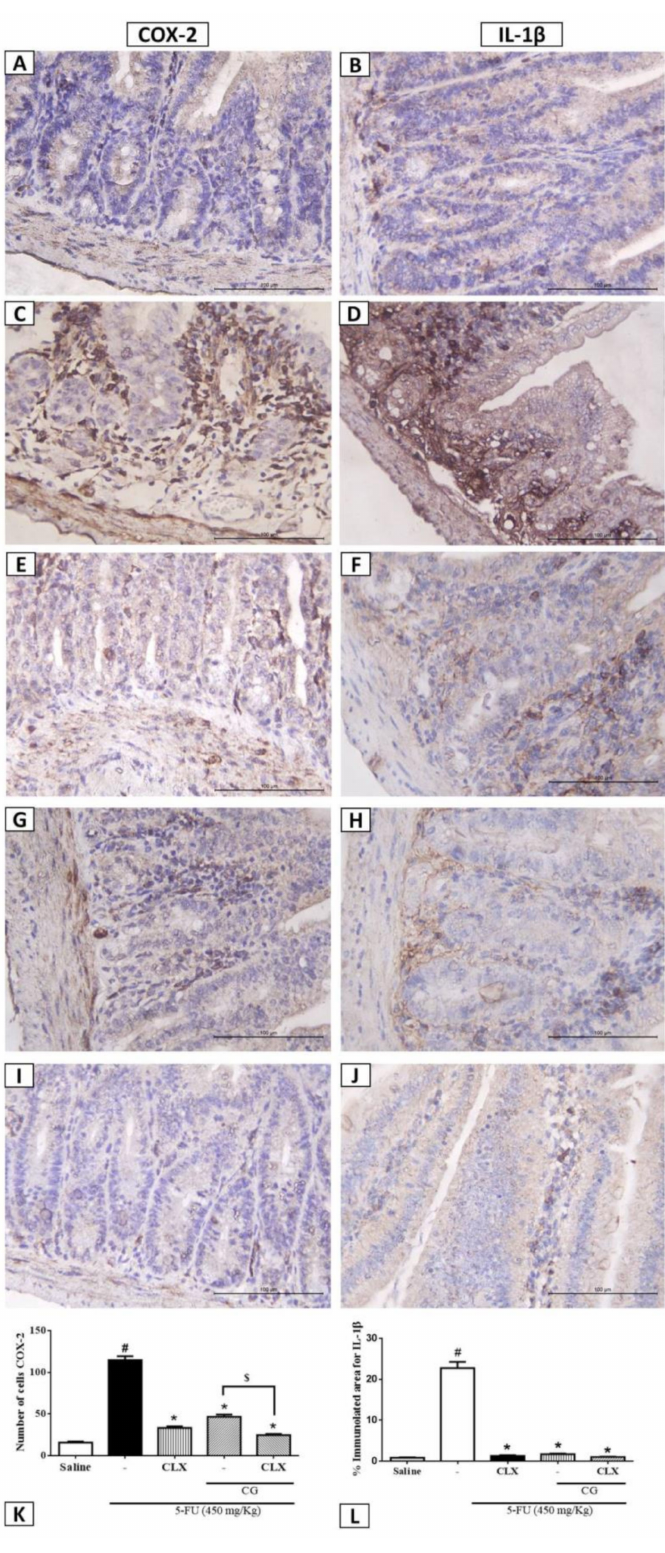
Figure 6. Immunohistochemistry analysis for COX-2 and IL-1 β . ( A , B ) Saline; ( C , D ) 5-FU; ( E , F ) CLX; ( G , H ) CG 90; ( I , J ) CLX + CG 90. ( K ) a number of cells immunolabelled for cox-2. ( L ) % immunolabelled for IL-1 β . Values were expressed as mean ± SEM. For statistical analysis, one-way ANOVA followed by Tukey´s test was used, where # p < 0.05 vs. saline group, * p < 0.05 vs. group 5-FU, $ p < 0.05 vs. group